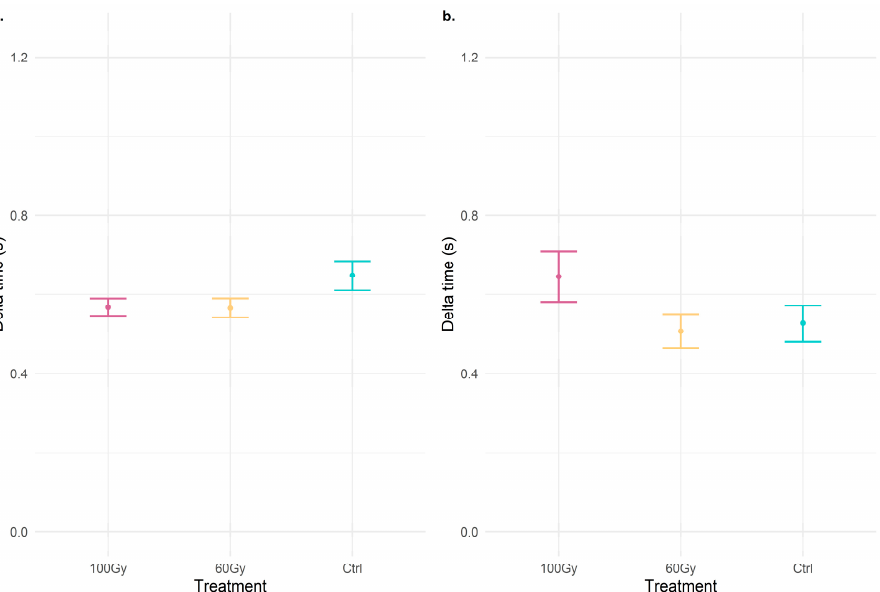
Figure 2. Dot plots with error bars of the delta time (s) of signals emitted during ( a ) the mounting phase and ( b ) mating. The dot represents the mean of delta time, and the error bar represents the standard error of the mean.